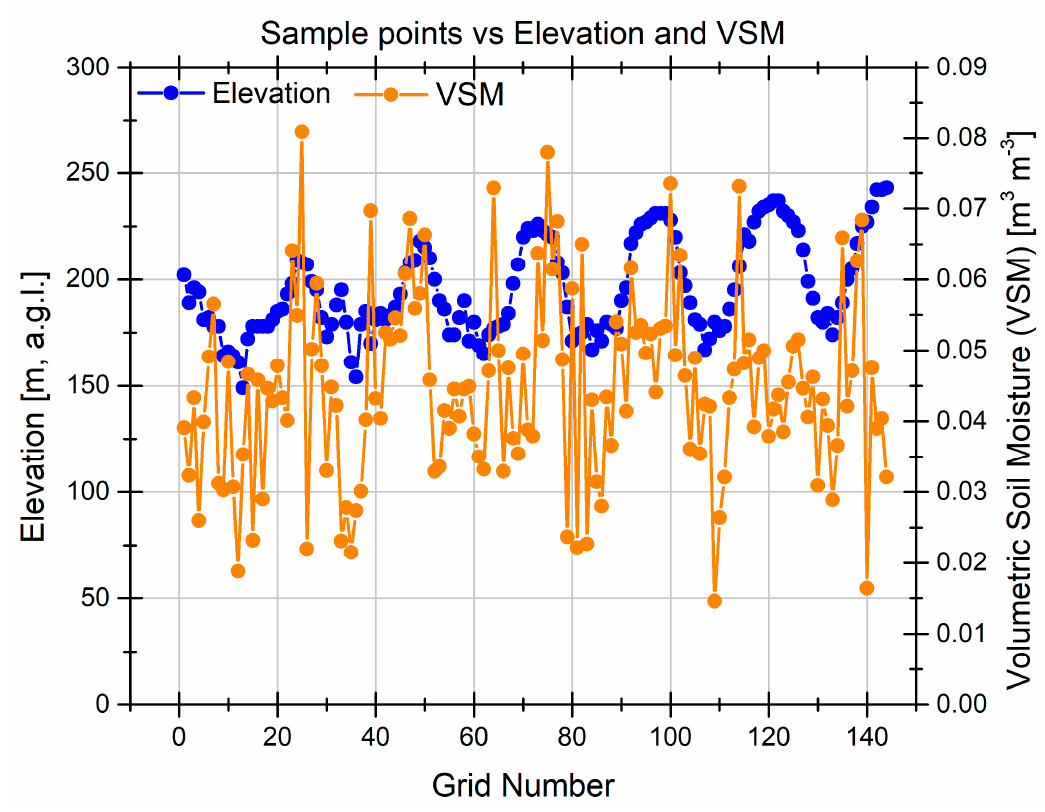
Figure 7. Terrain elevation versus volumetric soil moisture.